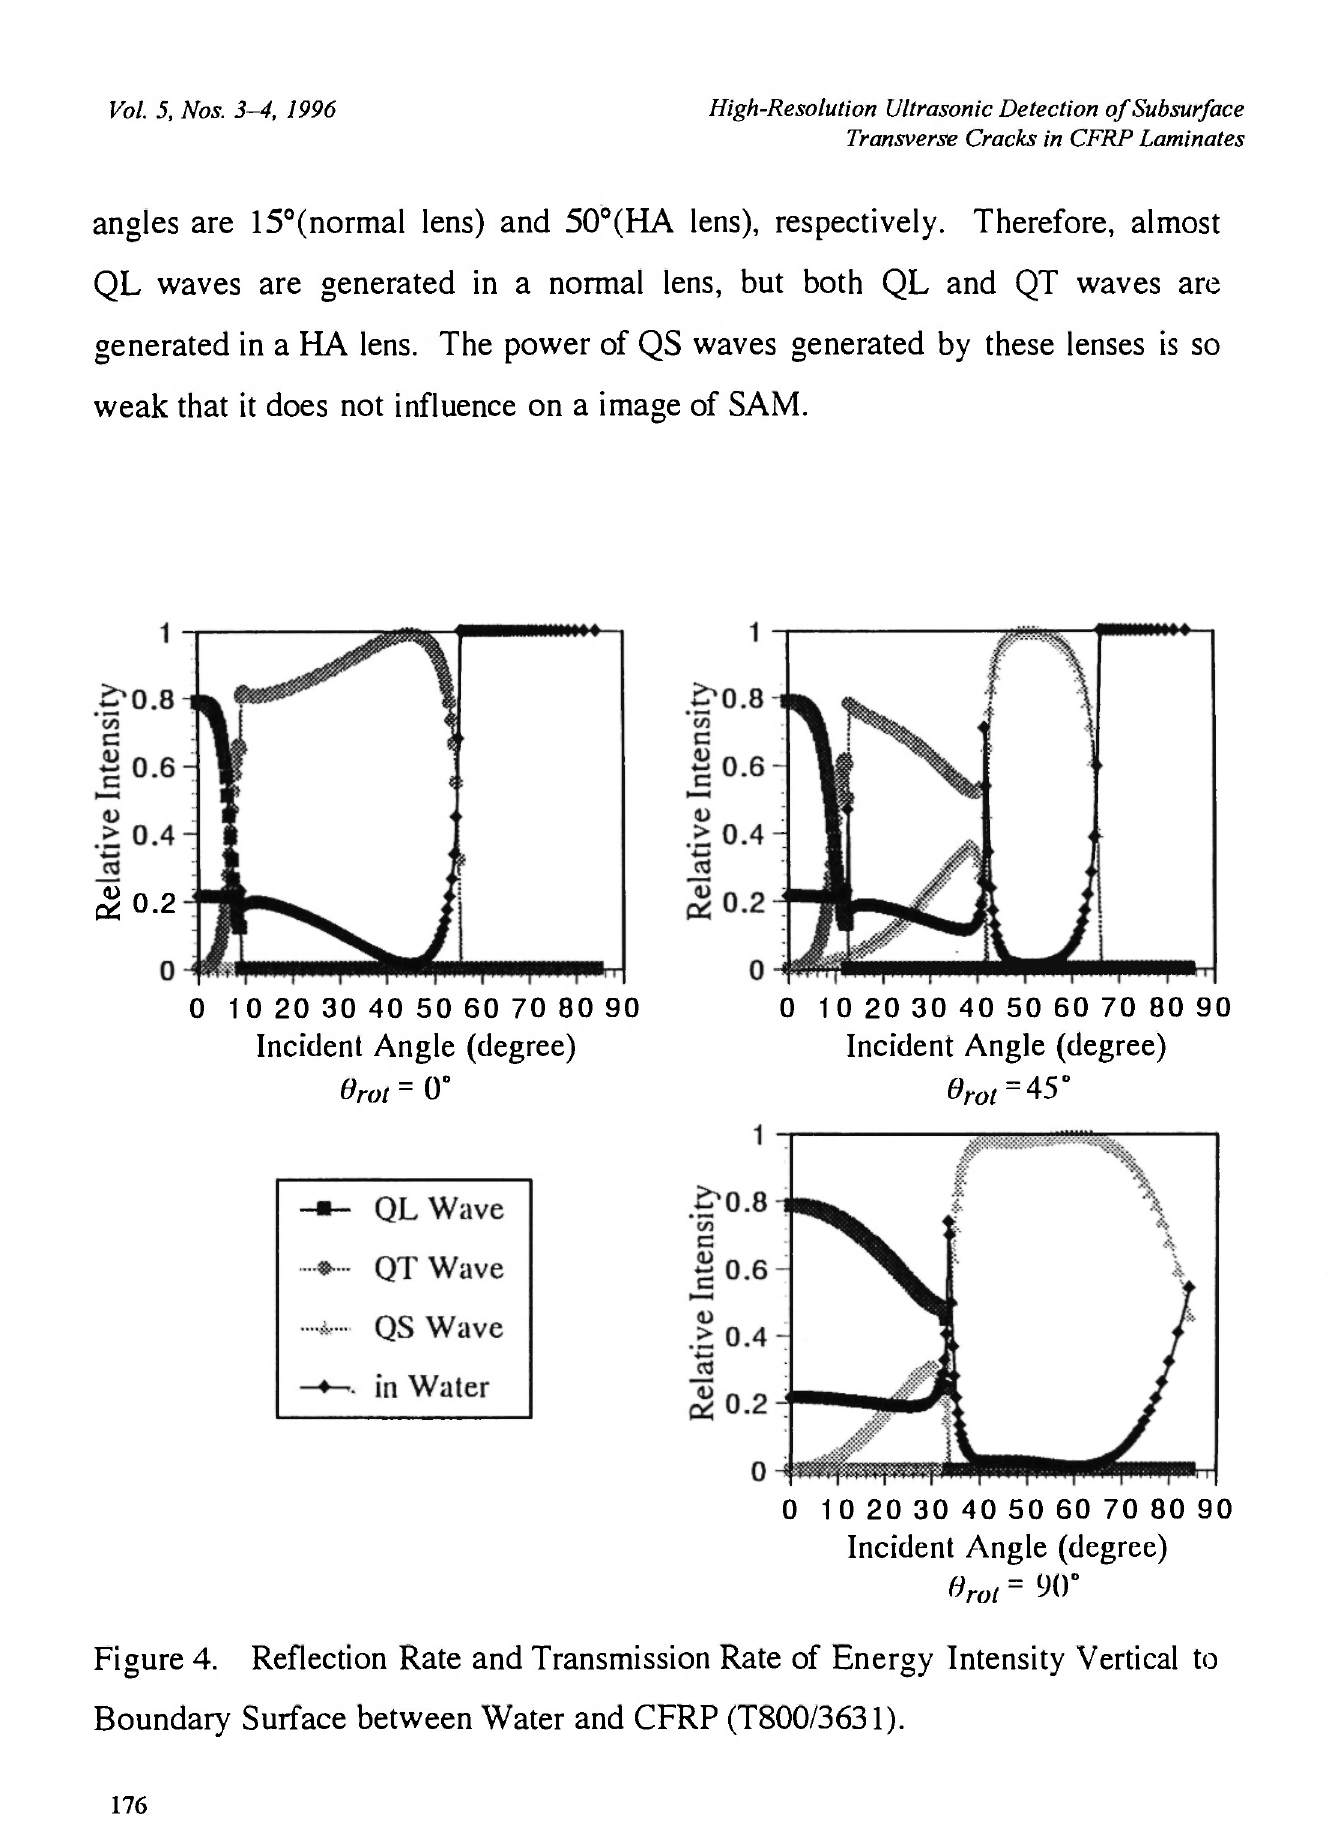
Figure 4. Reflection Rate and Transmission Rate of Energy Intensity Vertical to Boundary Surface between Water and CFRP